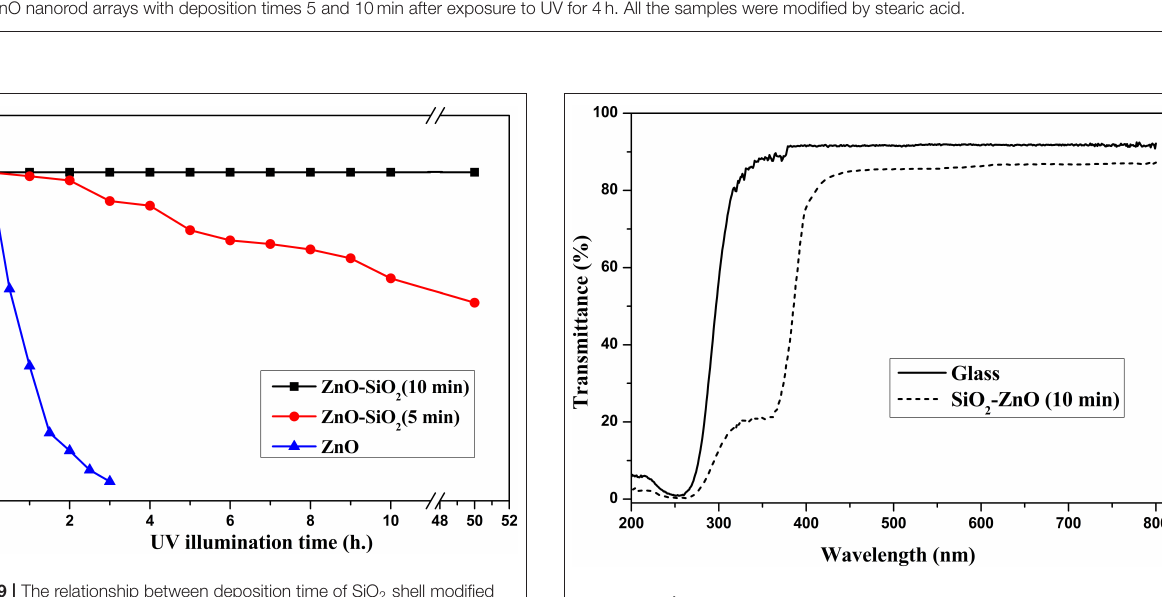
on the surface morphology and water contact angle is